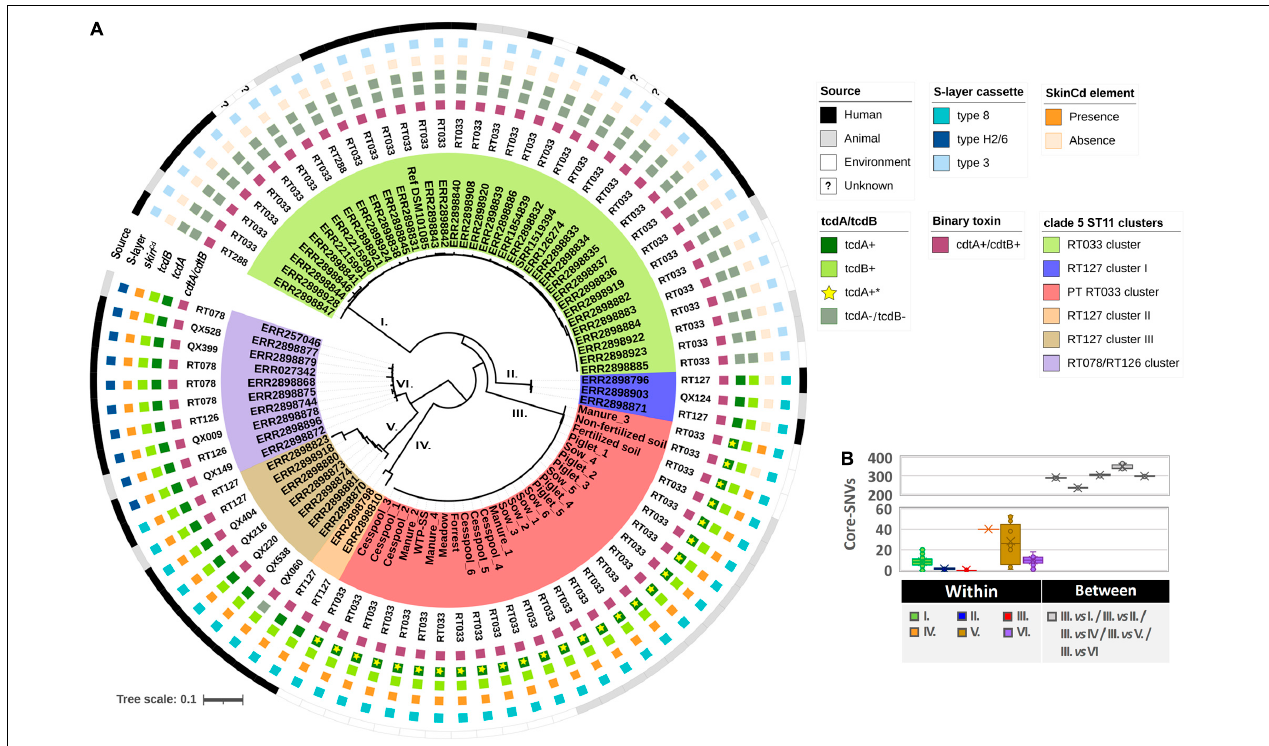
FIGURE 2 | Phylogenetic positioning of PT RT033 clone within in the Clostridioides difficile clade 5 ST11 lineage. (A) The core-genome SNP-based phylogenetic tree was reconstructed using the Neighbor-Joining method (Saitou and Nei, 1987) with the Maximum Composite Likelihood model (Tamura et al., 2004). For all isolates ( n = 84), the clade 5 ST11 sub-lineage (color-coded) is shown as well as the ribotype, the source, the S-layer cassette type, the skinCd element, the tcdA / tcdB and binary toxins. The tree was drawn using the iTOL website (https://itol.embl.de/) (Letunic and Bork, 2021). (B) Box Plots depicting the number of SNVs observed within and between all clade ST11 clusters. The horizontal line within each box marks the median, while the cross (“x”) represents the medium